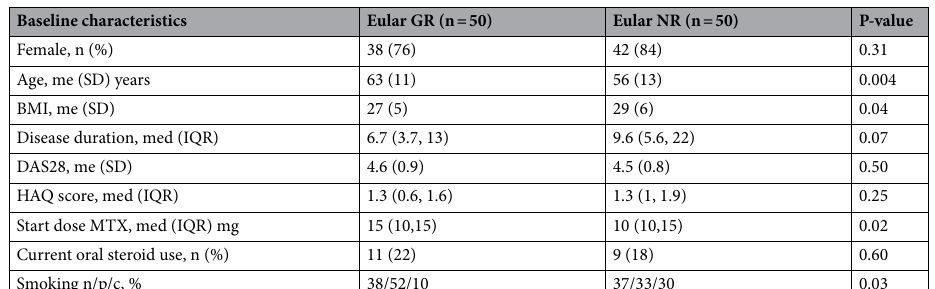
Table 1. Pre-treatment cohort characteristics. Disease duration is presented in months. P-value derived from t-test, Mann–Whitney and chi-squared tests where variables are described by mean, median and n(%), respectively. GR good-responder, NR non-responder, me mean, SD standard deviation, med median, IQR 25th and 75th percentile, HAQ health assessment questionnaire, MTX methotrexate, BMI body mass index, DAS28 28-joint count disease activity score, smoking (n = never, p = past, c =